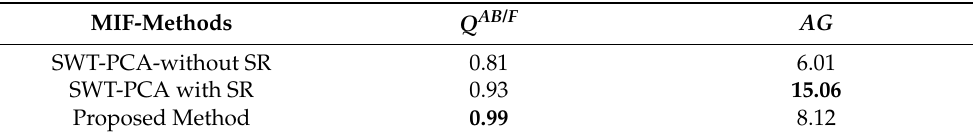
Figure 15. Multi-focus image of a Pepsi from various perspectives. Original Image: ( a ), Multi-focus Input Images: ( b , c ), and Proposed Fusion: ( d ). Table 9. The results and comparisons for Pepsi image